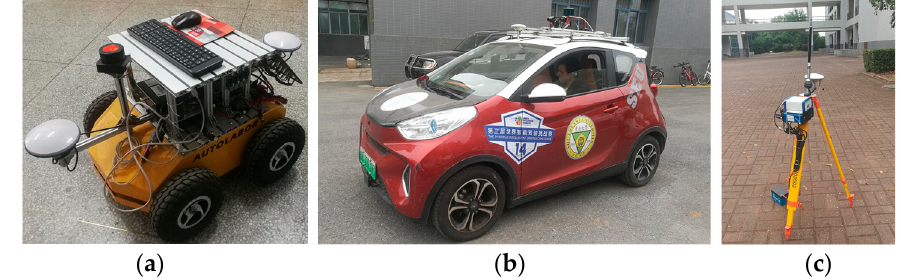
Table 2. The RMSE for different methods in the static experiment. Figure 9. Experiment equipment: ( a ) Unmanned ground vehicle; ( b ) Passenger car; ( c ) Base station.